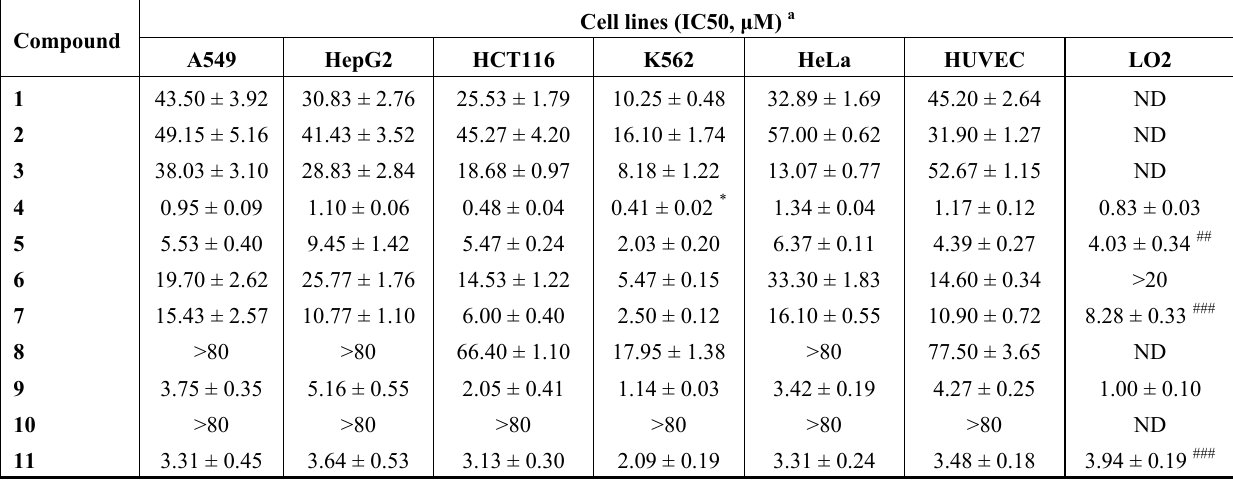
Table 4. Inhibition of cell proliferation by compounds 1 – 36 and